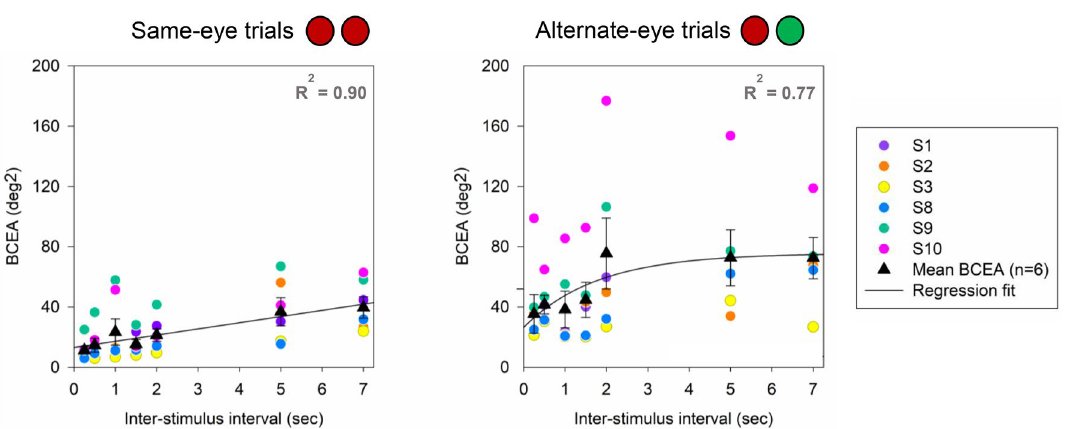
Figure 7. Scatter plot displaying BCEA and relationship with inter-stimulus interval (n = 6) for same-eye and alternate-eye conditions. Black triangles represent the mean and standard error in BCEA across subjects. Each color represents the BCEA for an individual subject. The black line denotes the model